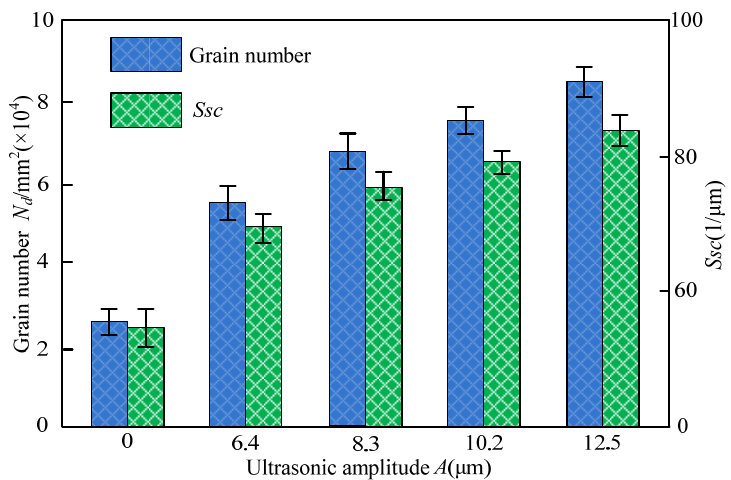
Figure 10. Variation of the number of grains and Ssc with ultrasonic amplitude.